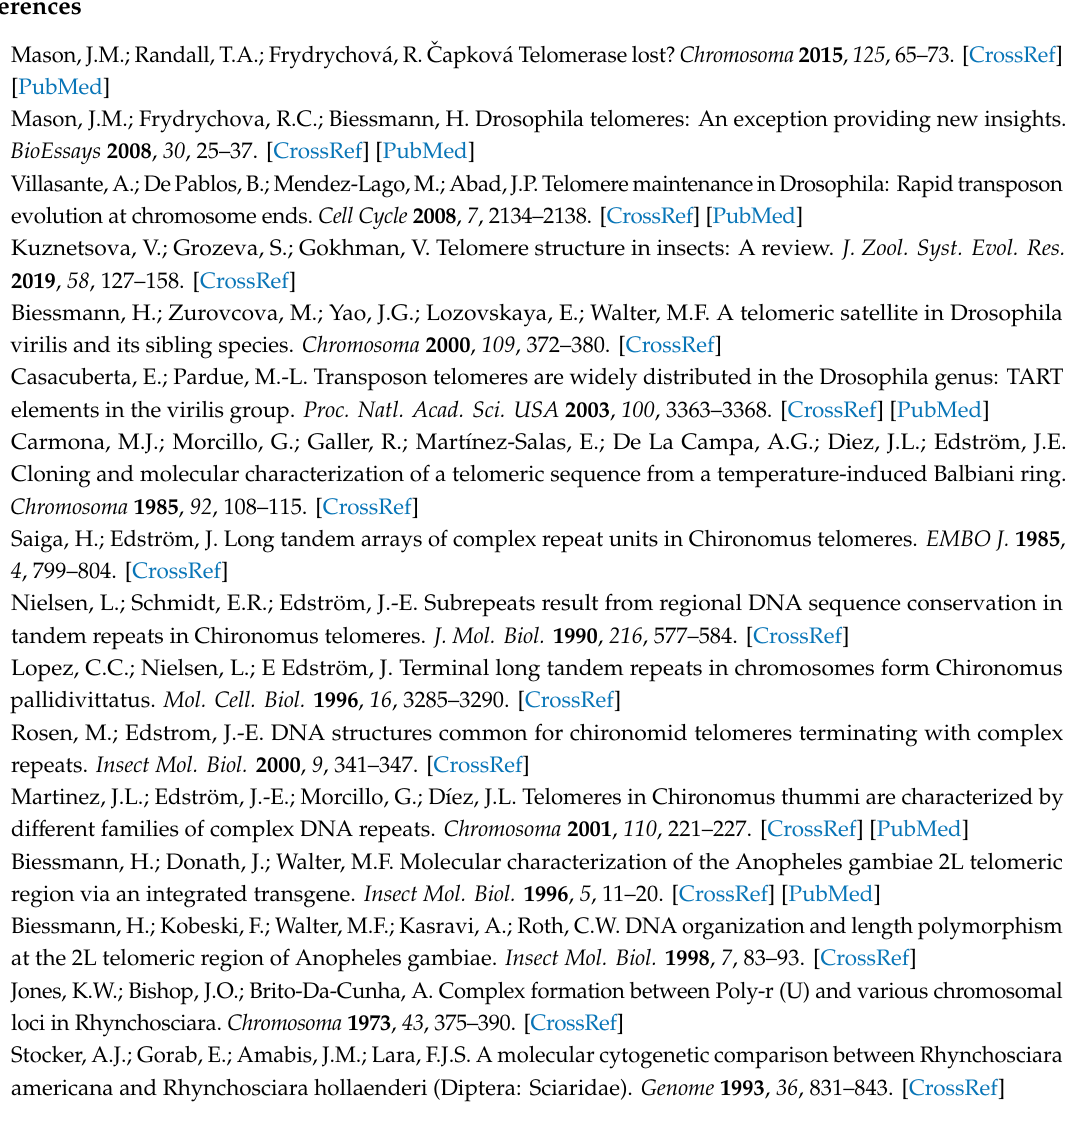
Figure S1: In situ hybridization using the X-1 probe in chromosomes of R. americana ; Figure S2: Sequences from the X-1 library of T. pubescens ; Figure S3: Localization of phage 2 probe in chromosomes of R. americana ; Figure S4: Localization of p Tp -1 probe in T. pubescens chromosomes; Figure S5. Partial sequence of p Tp -2.1 plasmid. Funding: This research was funded by Fundaç ã o de Amparo à Pesquisa do Estado de S ã o Paulo (FAPESP), grant 2017 /